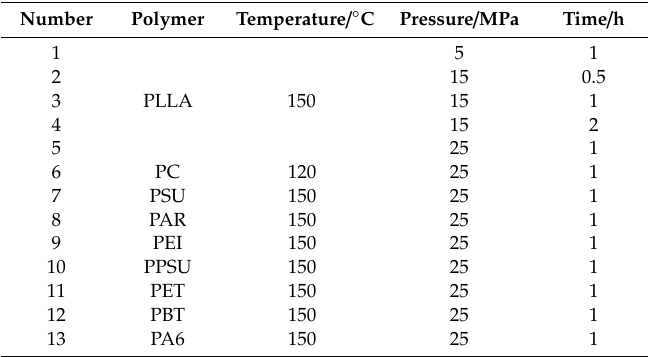
Table 2. Experimental